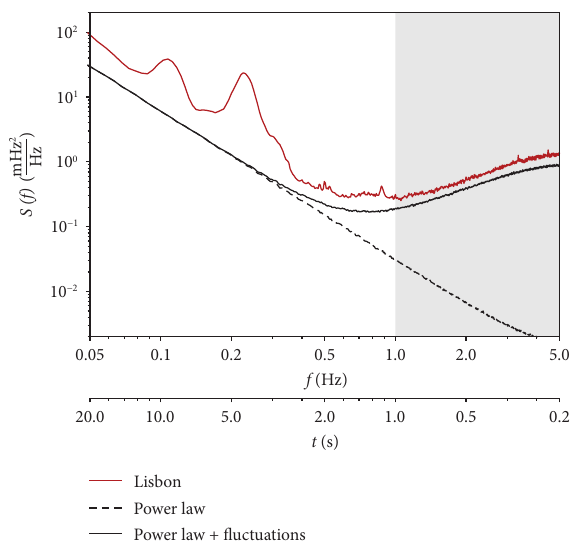
Figure 6: Reproducing the spectrum using an Ornstein-Uhlenbeck process with added correlated short-term